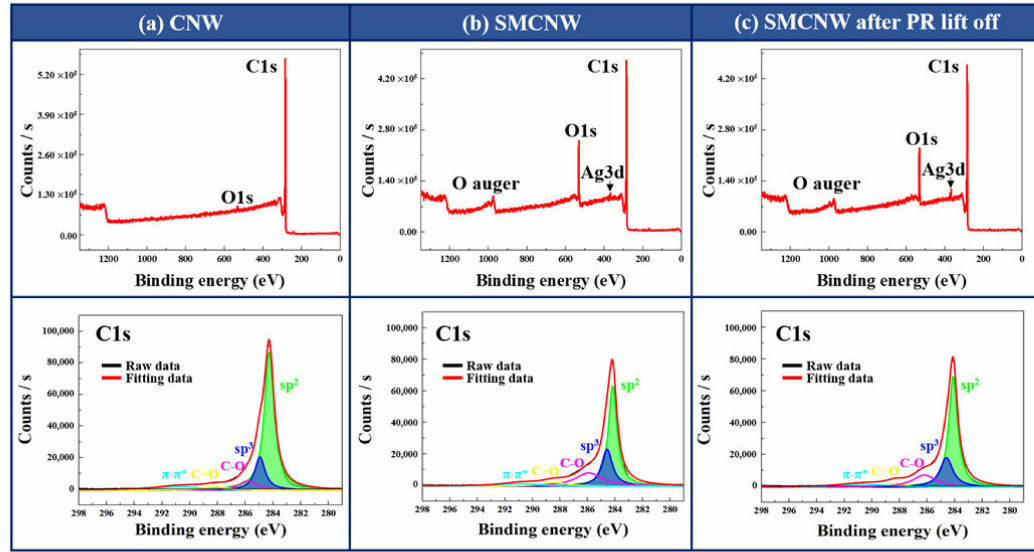
Figure 7. XPS analysis of the ( a ) CNW, ( b ) SMCNW, and ( c ) PR-removed